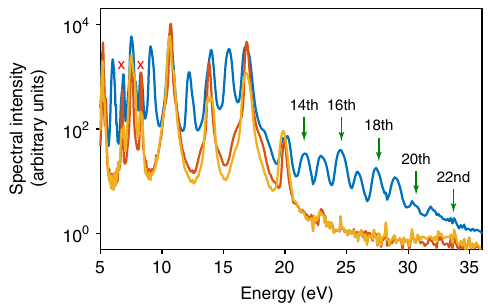
Fig. 1 High-harmonic generation from various forms of SiO 2 . Measured spectra generated from the crystalline α -quartz (solid dark blue line), polycrystalline SiO 2 (solid red line), and fused silica (solid orange lines) driven by linearly polarized 30fs pulses centered at 800nm. All measurements are performed at room temperature (300K). Each sample is exposed to the maximal non-damaging intensity ( ≈ 1.0V/Å — 3.8×10 13 W/cm 2 — in all three cases). Clear even harmonics can be seen up to 34eV (22nd harmonic